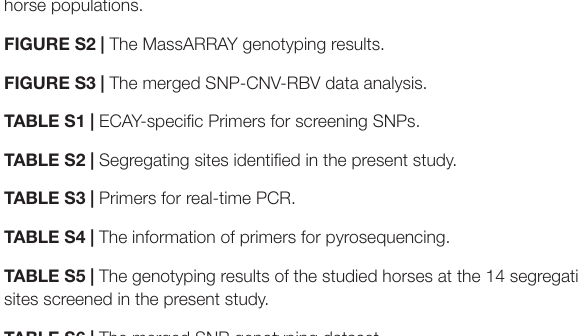
FIGURE S1 | Geographic distributions of sampled Chinese indigenous horse populations. FIGURE S2 | The MassARRAY genotyping results. FIGURE S3 | The merged SNP-CNV-RBV data analysis. TABLE S1 | ECAY-specific Primers for screening SNPs. TABLE S2 | Segregating sites identified in the present study. TABLE S3 | Primers for real-time PCR. TABLE S4 | The information of primers for pyrosequencing. TABLE S5 | The genotyping results of the studied horses at the 14 segregating sites screened in the present study. TABLE S6 | The merged SNP genotyping dataset. TABLE S7 | The CNVs of the DNA fragments containing the 11 segregating sites. TABLE S8 | The merged SNP-CNV-RBV data. The CNVs of each site were divided into two types by median ( < median, A; ≥ median, B). Letters (A–G) represented the Ratios of Base Variant